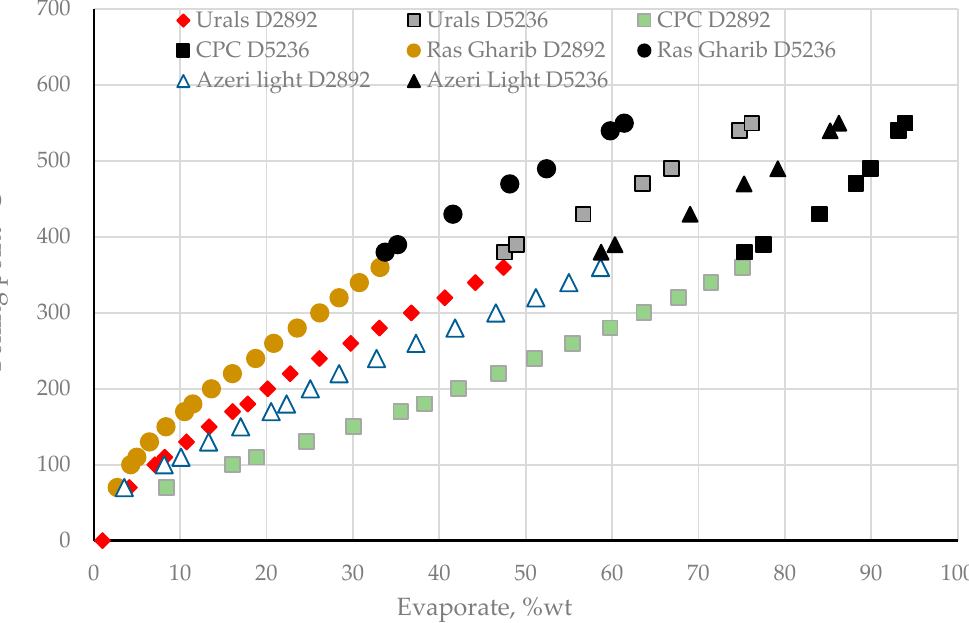
Figure 5. TBP distillation curves using ASTM D 2892 and ASTM D 5236 analysis data for extra light (CPC), light (Azeri Light), medium (Urals), and heavy (RasGharib) crude oils.